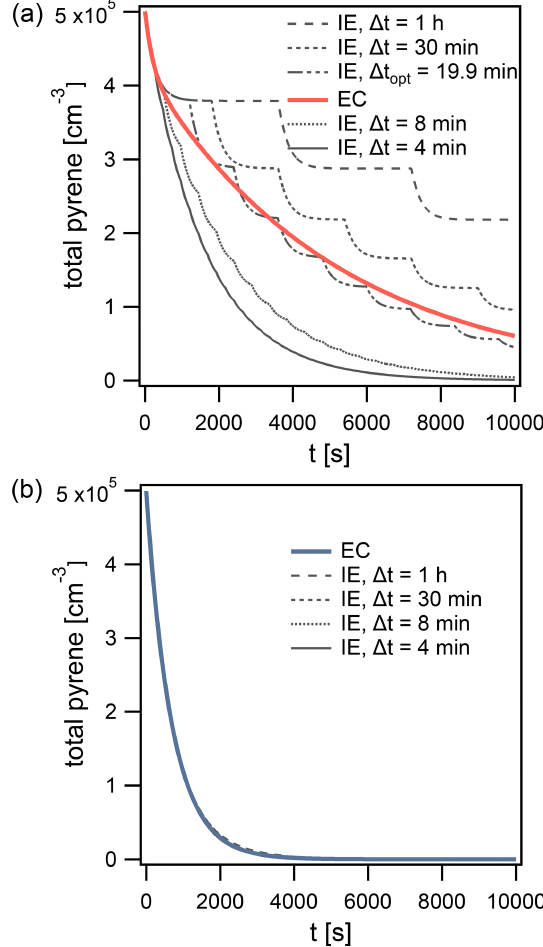
Figure 7. Time evolution of total pyrene concentration in model calculations, comparing the explicitly coupled (EC) solution to the operator splitting with instantaneous-equilibration (IE) solution ( (cid:49)t = 4, 8, 30min and 1h) for systems with (a) surface reaction of particle-phase pyrene with 100ppb O 3 and (b) reaction of gas- and surface-bound pyrene with 1ppt OH. The operator-splitting time step leading to the smallest deviation is depicted as (cid:49)t opt